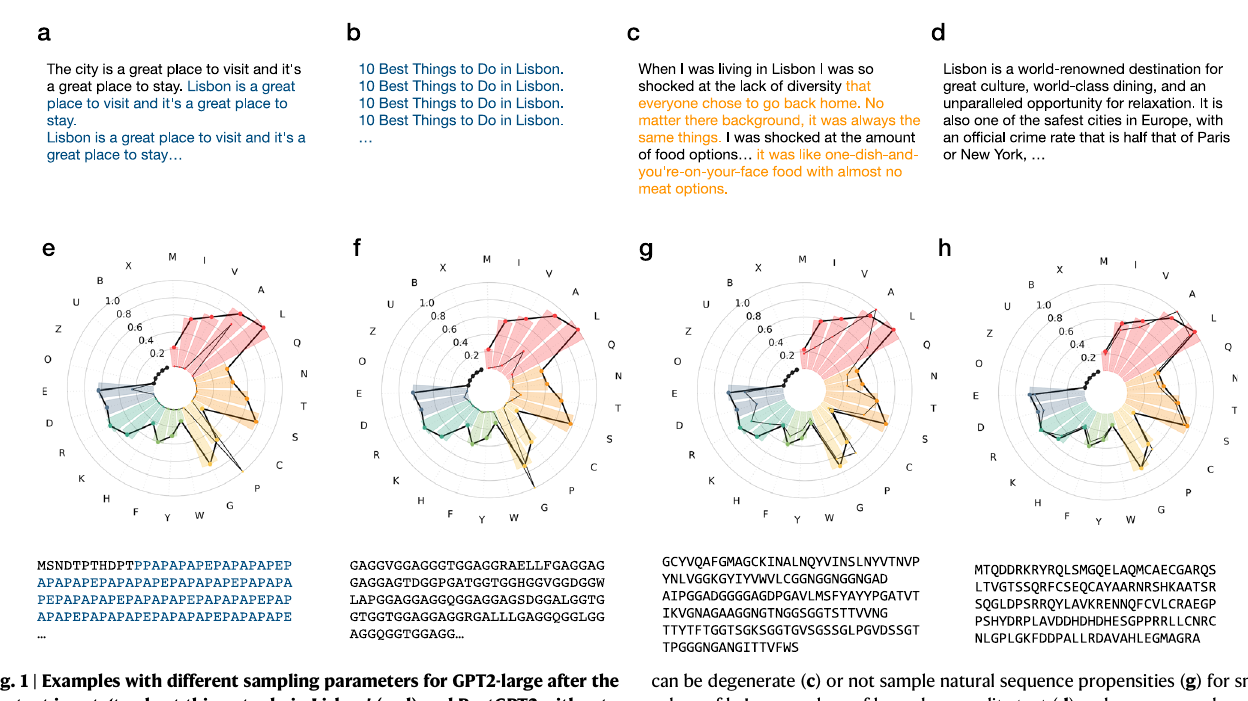
can be degenerate ( c ) or not sample natural sequence propensities ( g ) for small values of k. Larger values of k produce quality text ( d ) and sequences whose pro- pensities match natural ones. Repetitive and degenerative text are shown in blue and orange, respectively.